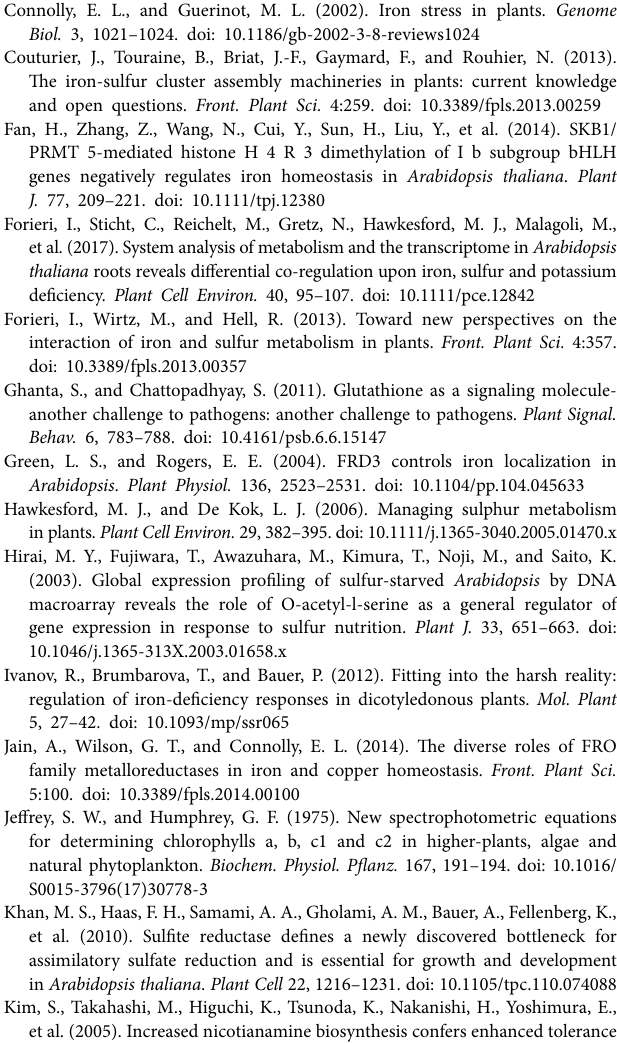
Supplementary Figure S1 | Phenotypes of 14-days old seedlings under Fe- deficient conditions. Top view of the seedlings directly germinated on Fe-deficient half-strength MS medium for 14 days. Supplementary Figure S2 | Expression analysis of AtFH in the double overexpressor OxFIT X OxbHLH38 . Relative expression by Quantitative RT-PCR of the genes CyaY/frataxin in roots,for Arabidopsis the wildtype (Col-0) and the double overexpressor line OxFITXOxbHLH38 of one-week old seedlings exposed to half-strength MS medium (1/2 MS +Fe +S), Fe deficient (1/2 MS -Fe +S), S deficient (1/2 MS +Fe -S) and Fe & S deficient (1/2 MS –Fe -S) media for four days under long-day conditions. The y-axis shows RNA levels normalized to that of GADPH. Letters indicate the statistically significant differences among all treatments in Col-0 and doubleoverxpresser line determined with the two-way ANOVA test followed by Tukey’s test (P < 0.05, n = 3). Bars represent means